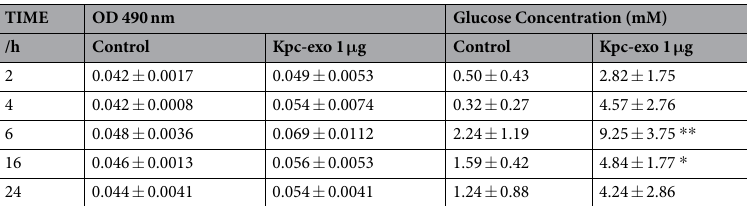
Table 1. The optical density values and glucose concentrations of supernatants after incubations with KPC- exosomes for different times. The original glucose concentration of the supernatants was 15 mM. n = 4/each time point·group. Values are the MEAN ± SD. * p < 0.05 vs Control. ** p < 0.01 vs